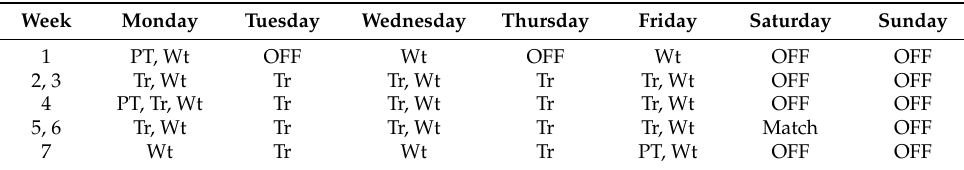
Table 1. Overall schedule for 7